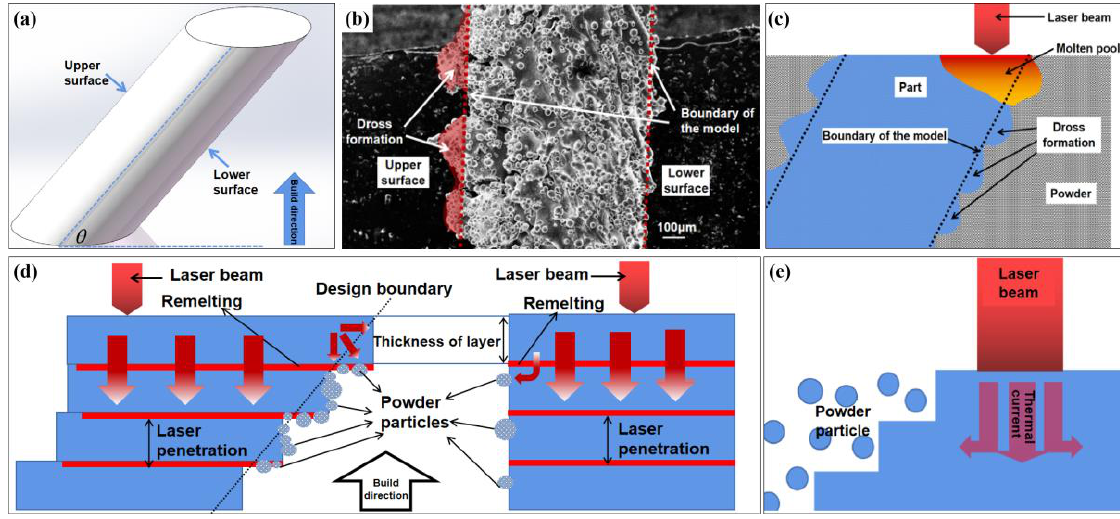
Figure 5. Surface roughness of inclined micro-rods and its primary causes: ( a ) definition of upper and lower surfaces of the inclined micro-rods; ( b ) SEM to exhibit a difference in surface roughness morphology between the upper and lower surfaces of the inclined micro-rods; ( c ) schematic of dross formation; ( d ) schematic relationship between the unmelted powder adhesion and the outer surface morphology of inclined and vertical micro-rods; ( e ) the laser heat-input energy dissipation causing the powder adjacent to the outer surface not to be completely